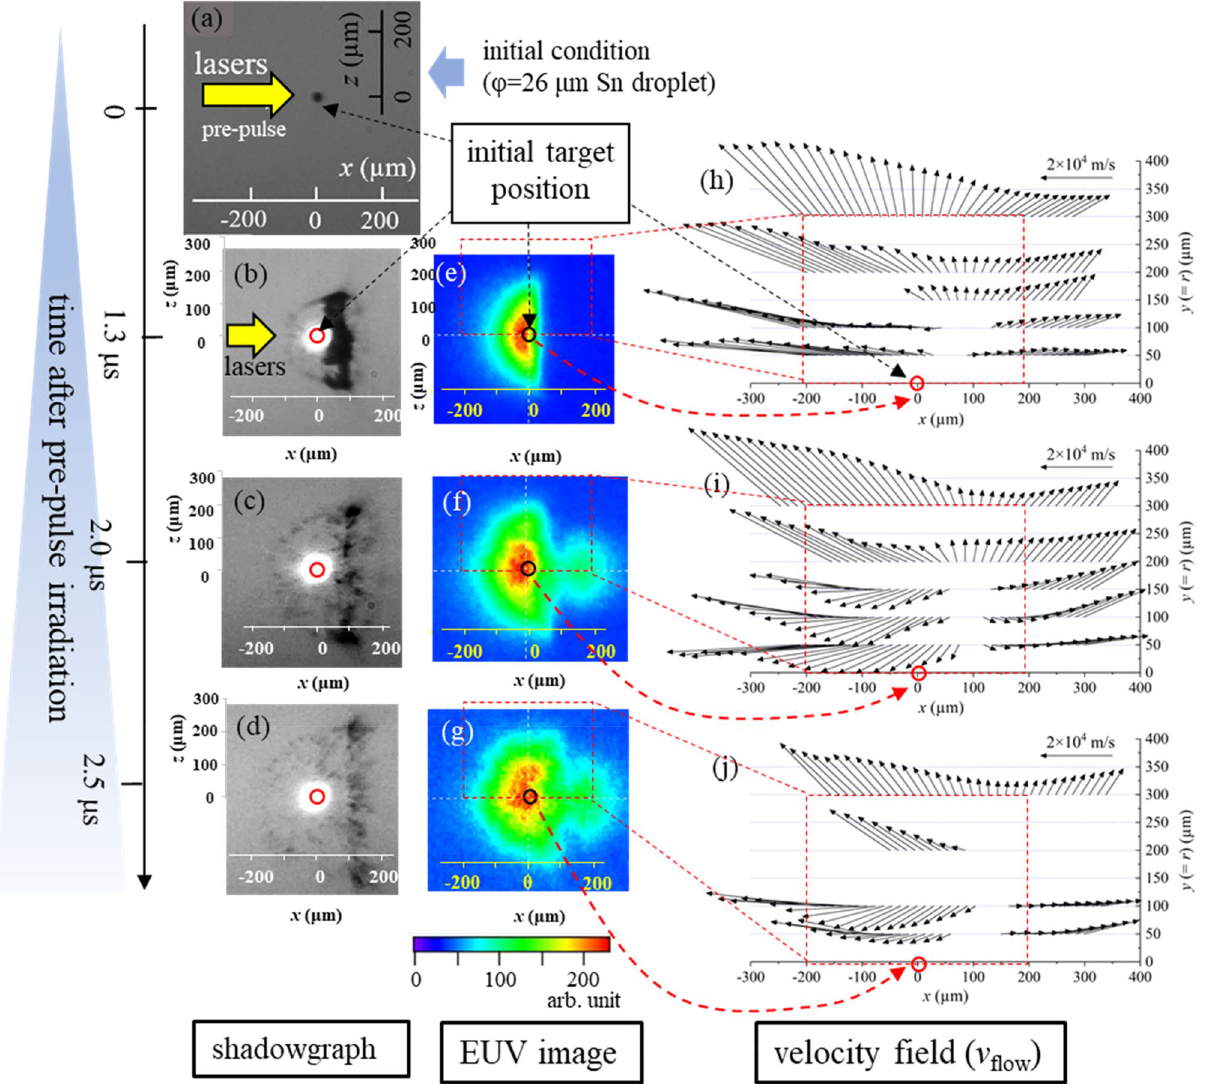
Figure 2. ( a – d ) Shadowgraphs of the Sn droplet target before ( a ) and after 1.3 μs ( b ), 2.0 μs ( c ), and 2.5 μs ( d ) irradiating the pre-pulse lasers. ( e – g ) Line-integrated in-band EUV images of the 1.3 μs-plasma,